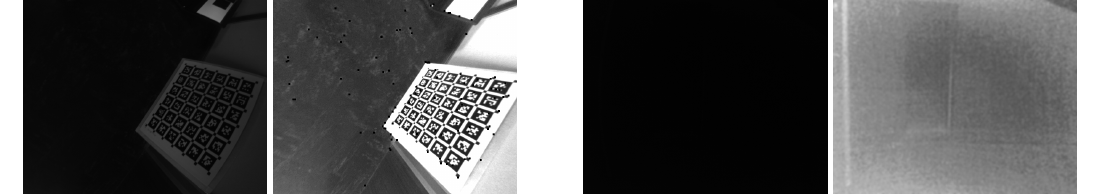
Figure 5. Image processing pipeline. ( Left ): Raw input images. ( Right ): after rectification, intensity normalization, and corner detection. On the second example, the normalization reveals a faint signal, but it is too noisy for corner detection to